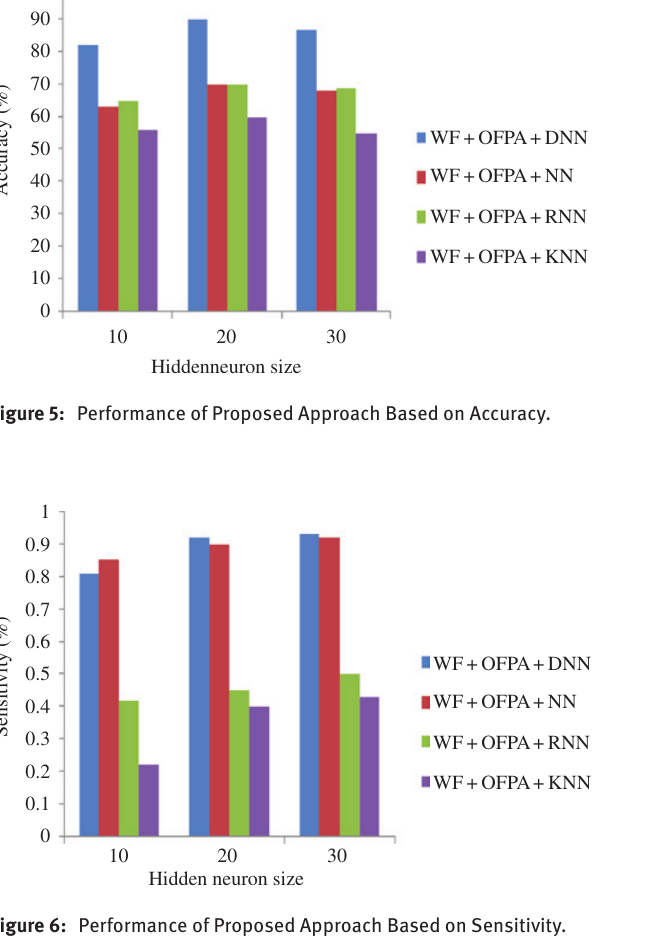
Figure 6: Performance of Proposed Approach Based on